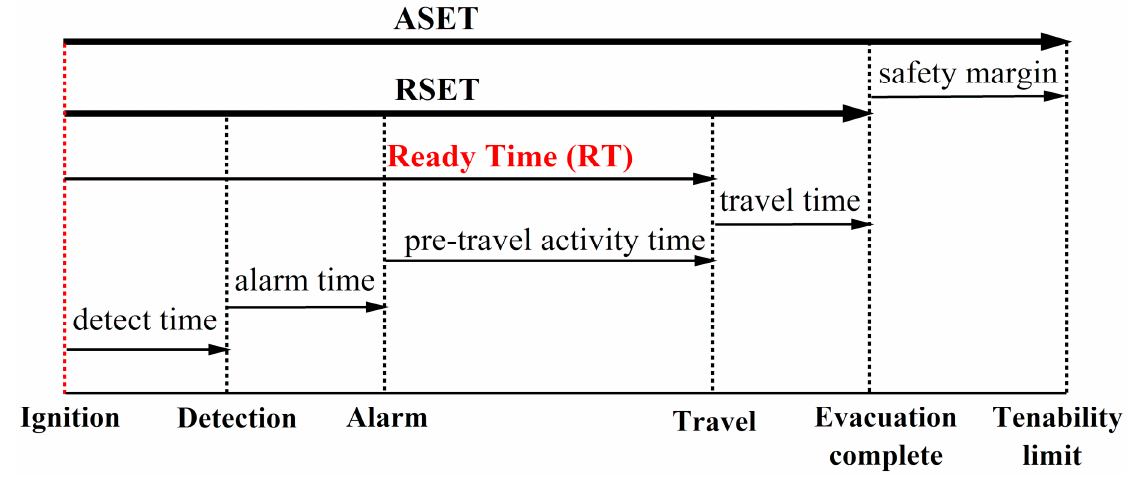
Figure 4. The relationship between the available safe escape time (ASET) and the required safe escape time (RSET) in evacuation process. Table 7. RT of evacuation in different distance from the fire